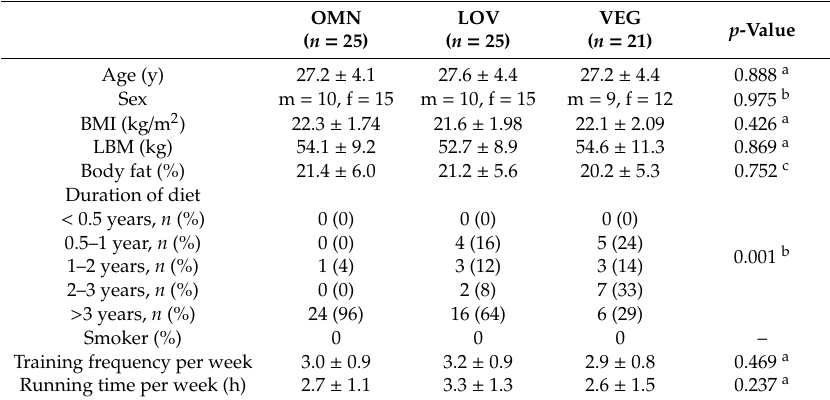
Table 1. Participant characteristics by dietary patterns of the study